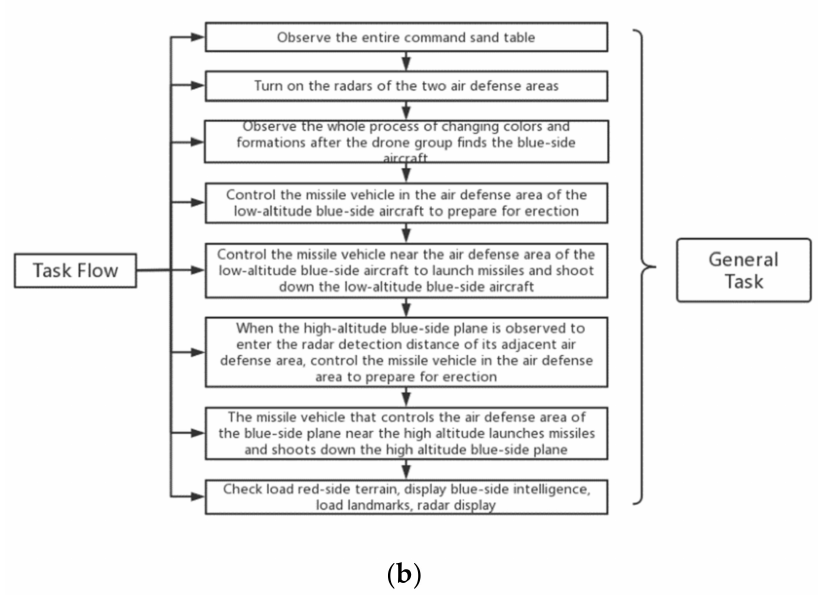
Figure 11. Experiment flowchart and task flow ( a ): Experimental process, ( b ): Task flow.